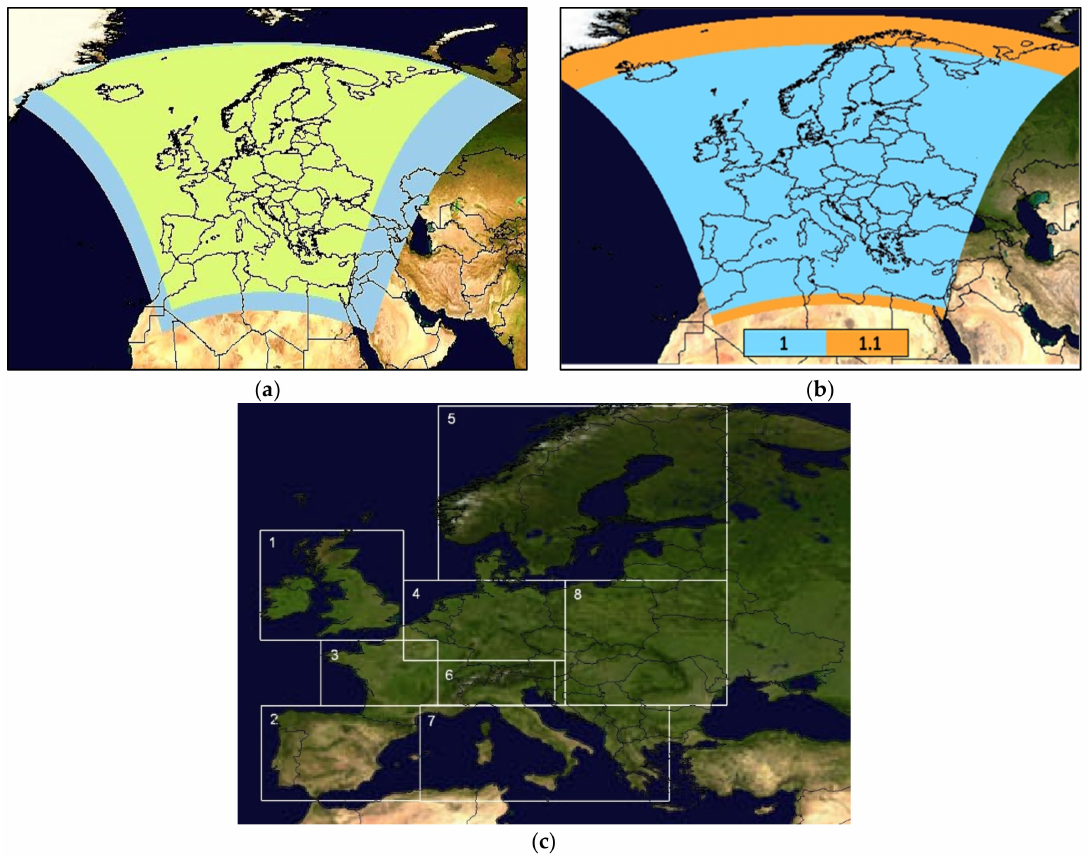
Figure 1. Domain setup ( a ) WRF model domains at 0.75 ◦ and 0.25 ◦ grid size resolutions ( b ) WRF domain map factor, ( c ) the subregions considered, where 1. BI, 2. IP, 3. FR, 4. ME, 5. SC, 6. AL, 7. MD, 8.